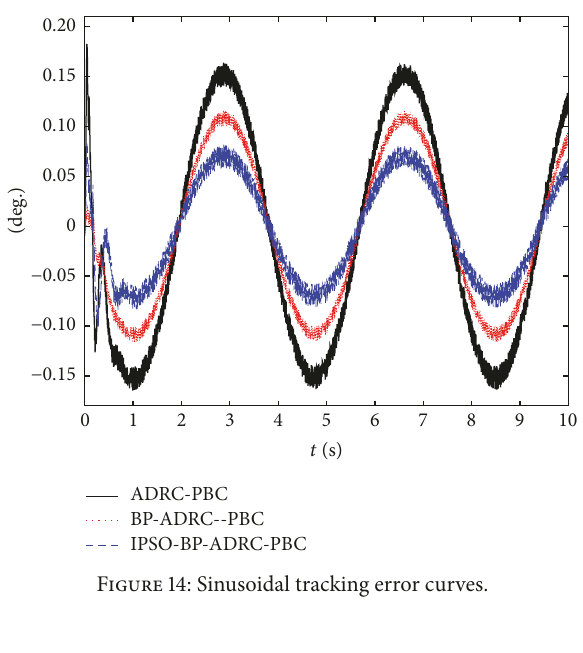
Figure 14: Sinusoidal tracking error